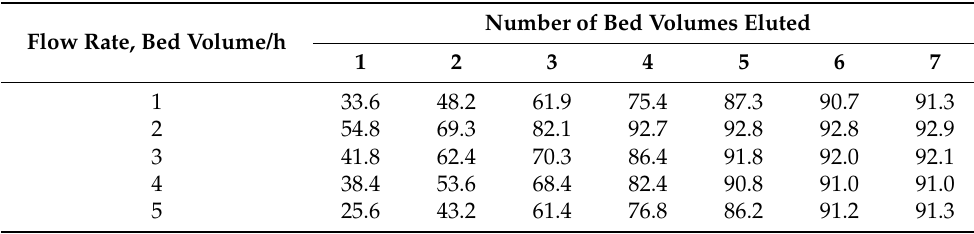
Table 5. Desorption ratio of total cucumber flower flavonoids on Amberlite XAD-2 at various flow